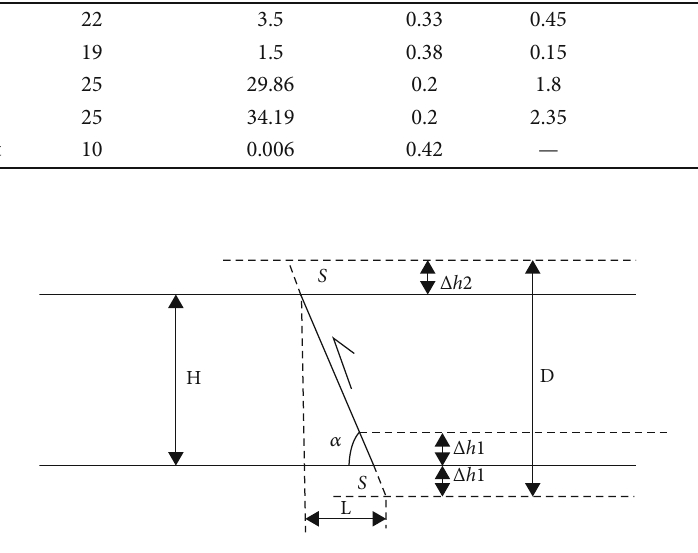
Figure 3: Diagram of clearance change of the tunnel lining segment under reverse fault dislocation.